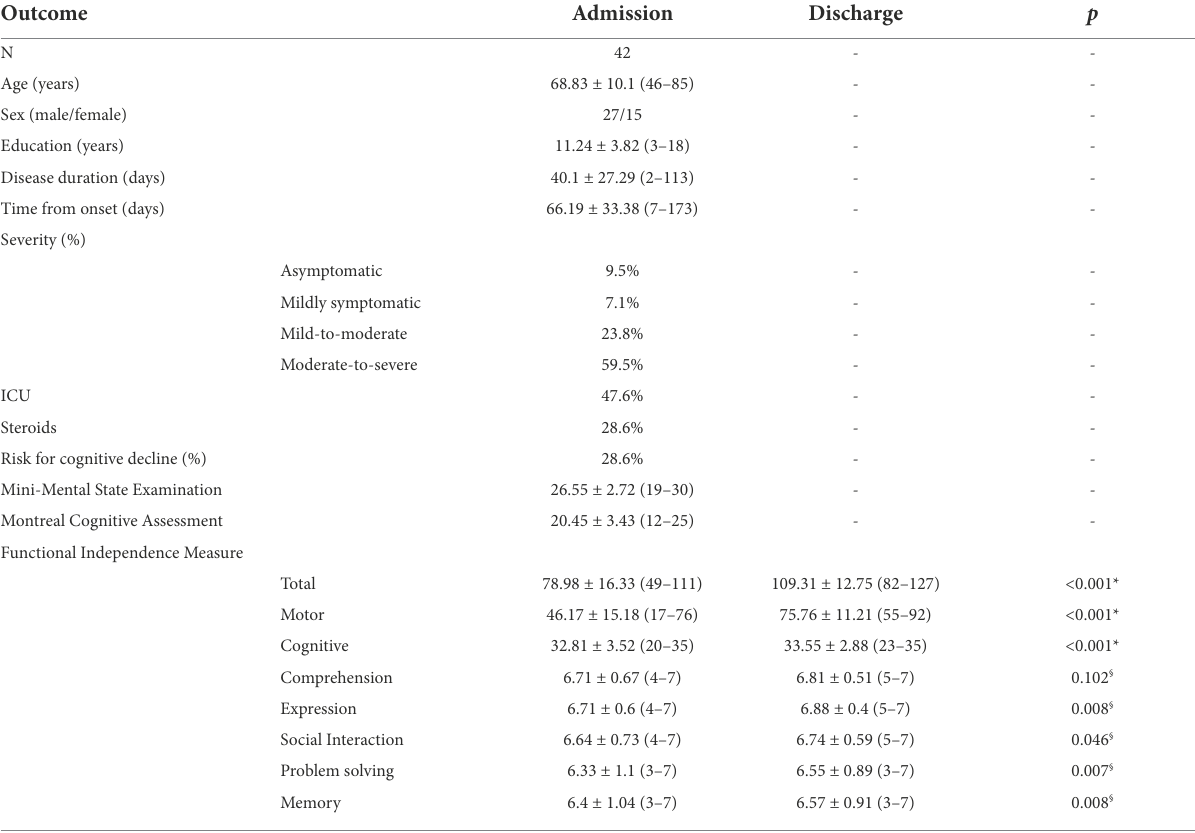
TABLE 1 Patients’ background and clinical